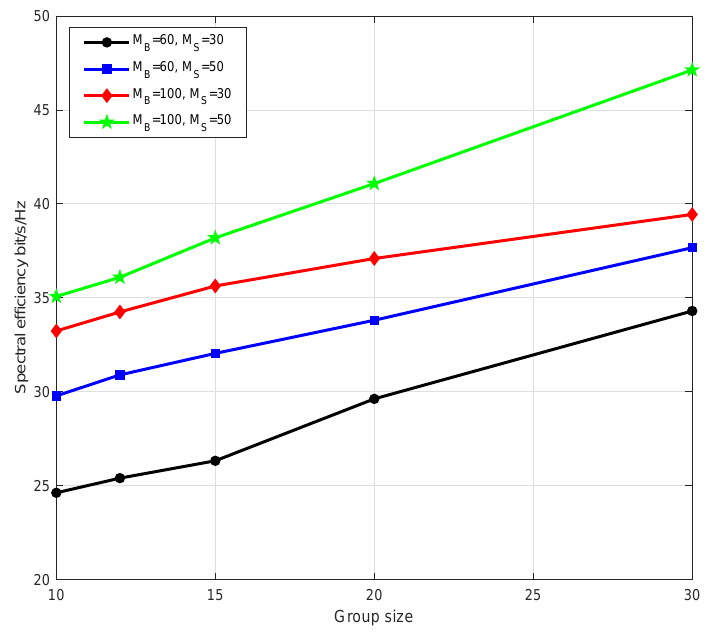
Figure 5. System spectral efficiency of different group